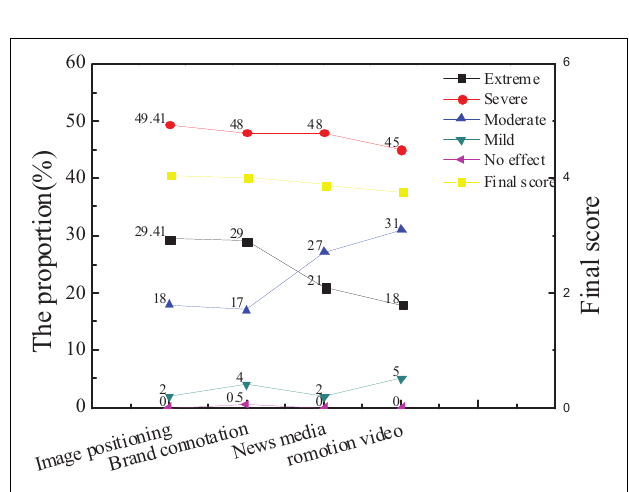
FIGURE 14 | Attention of the audiences to influencing factors of city communication image.